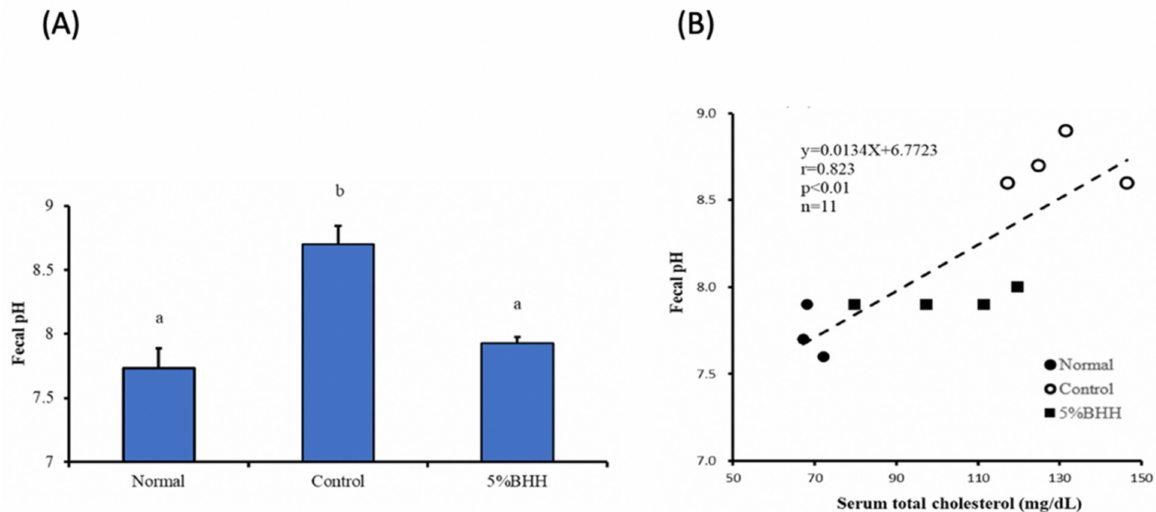
Figure 2. Effect of BHH on fecal pH ( A ) and the relationship between serum cholesterol and fecal pH ( B ). Bars in ( A ) are the average ± SD ( n = 3 (Normal), n = 4 (Control and 5% BHH)). Different letters above the bars indicate significant